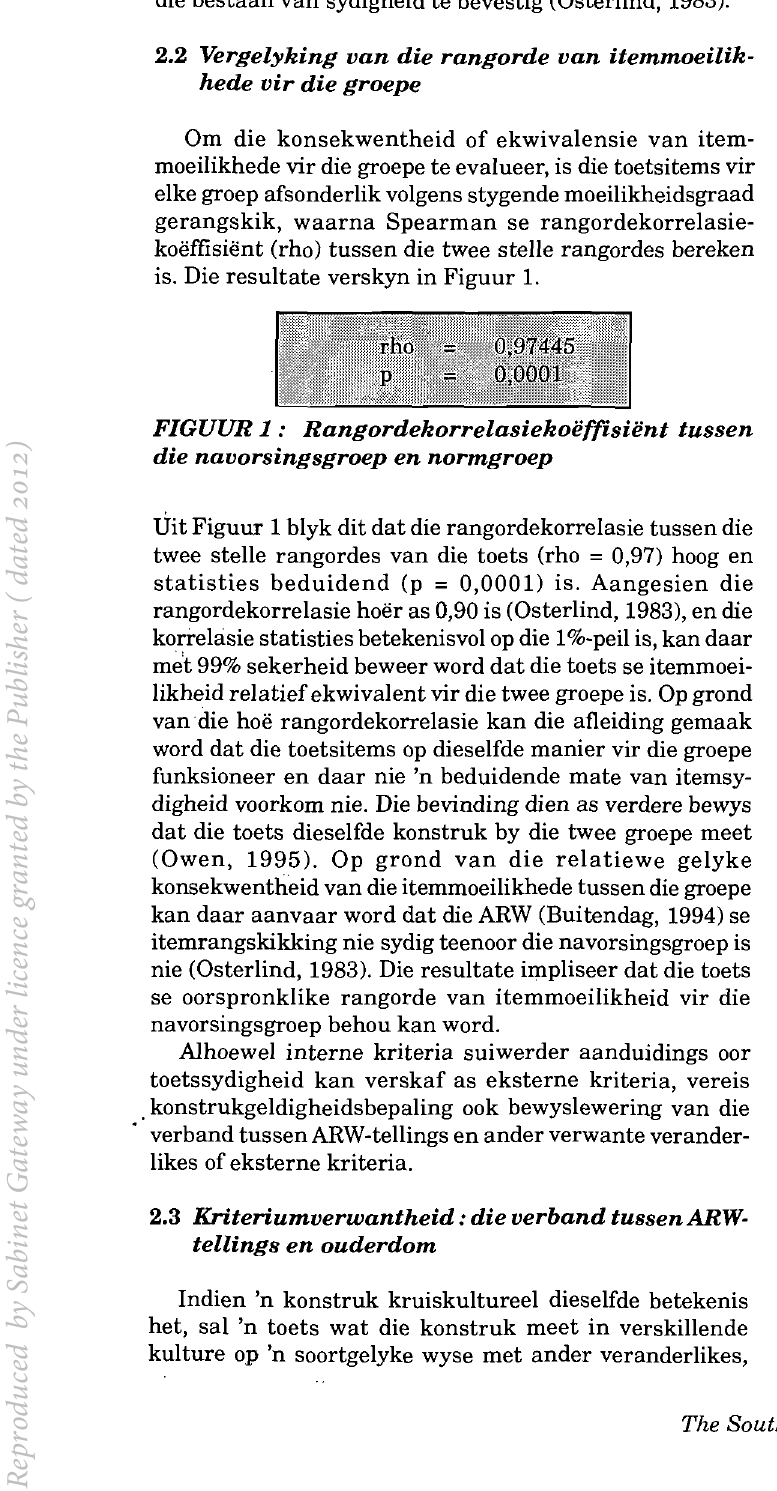
FIGUUR 1: Rangordekorrelasiekoeffisient tussen die navorsingsgroep en normgroep Uit Figuur 1 blyk dit dat die rangordekorrelasie tussen die twee stelle rangordes van die toets (rho = 0,97) hoog en statisties beduidend (p = 0,0001) is. Aangesien die rangordekorrelasie hoer as 0,90 is (Osterlind, 1983), en die korrehisie statisties betekenisvol op die 1 %-peil is, kan daar met 99% sekerheid beweer word dat die toets se itemmoei likheid relatief ekwivalent vir die twee groepe is. Op